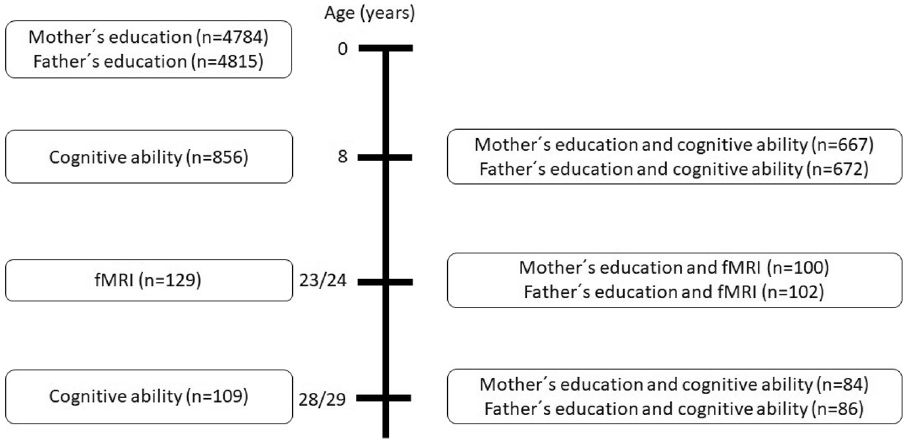
Figure 2. Number of participants in analytical